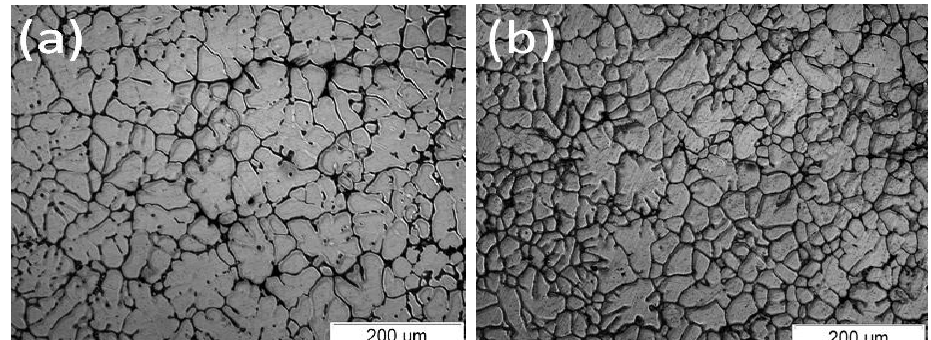
Figure 4. Optical micrographs of the squeeze cast sample ( a ) 15 MPa; ( b ) 30 MPa; ( c ) 60 MPa; and ( d ) 90 MPa applied